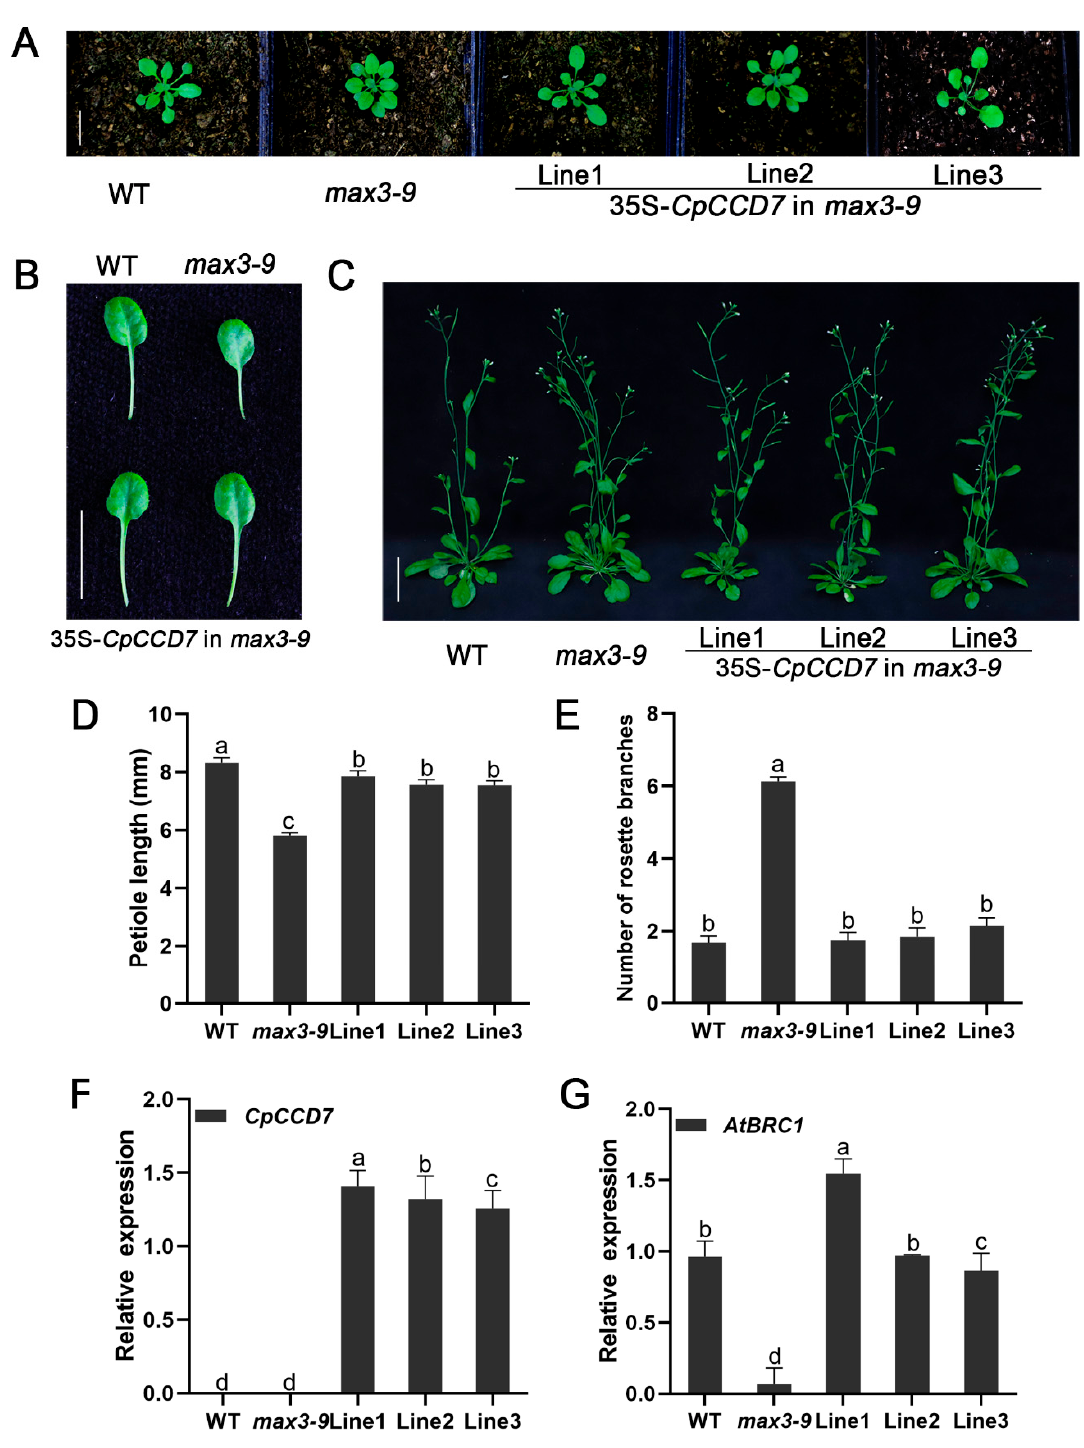
Figure 6. CpCCD7 overexpression restores the phenotype of the Arabidopsis branching mutant max3-9 . ( A ) Seedlings grown in soil for 2 weeks. ( B ) Petiole phenotype of WT, max3-9 and restored lines 1–3 grown in soil for 2 weeks. ( C ) Branching phenotype of WT, max3-9 and complementation lines 1–3 grown 35 d after transplant. In ( A – C ), scale bars = 5 mm. ( D ) Petiole length of WT, max3-9 and plants grown in nutrient-rich soil for 2 weeks. ( E ) Number of rosette branches in WT, max3-9 mutant and CpCCD7 complementation lines 1–3. Data represent mean ± SE ( n = 12–46). ( F , G ) Expression levels of CpCCD7 and AtBRC1 in WT, max3-9 mutant and CpCCD7 restored lines 1–3 (data represent mean ± SD of three biological replicates). The leaves and axillary buds of WT and restored lines were collected used for qRT-PCR analysis at 35 d after transplant. Different lowercase (a–d) above the bars indicates significant differences ( p < 0.05).